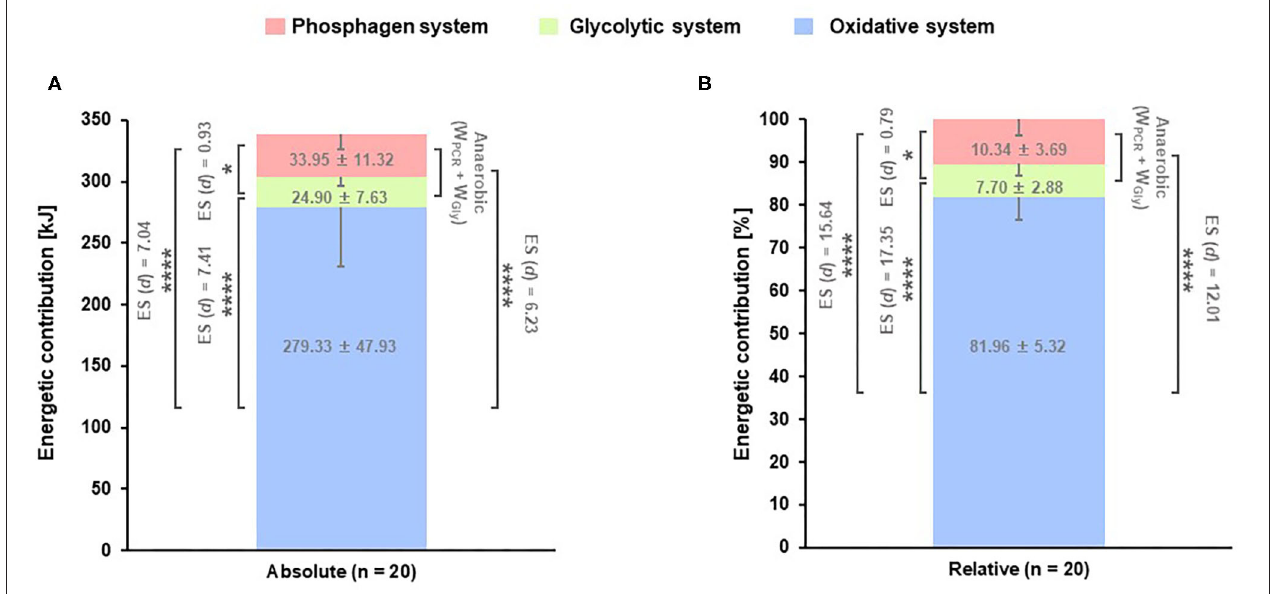
SD . (A) Absolute and (B) relative energetic contribution during high-intensity hatha yoga. * p < 0.05 (phosphagen vs. FIGURE 3 | Energetic contribution. M ± glycolytic energy contribution), **** p < 0.0001 (oxidative vs. glycolytic energy contribution), **** p < 0.0001 (oxidative vs. phosphagen energy contribution), **** p <